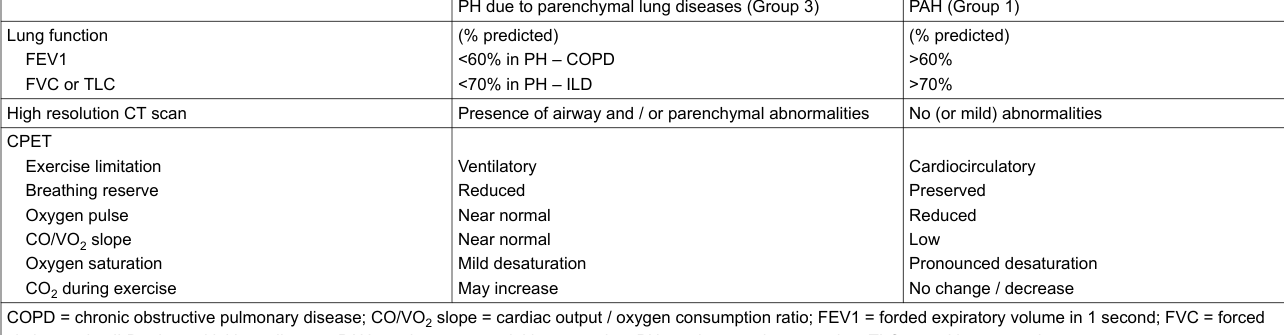
Table 2: Current haemodynamic classification of pulmonary hypertension due to lung diseases (adapted from [1]). COPD/ILD without